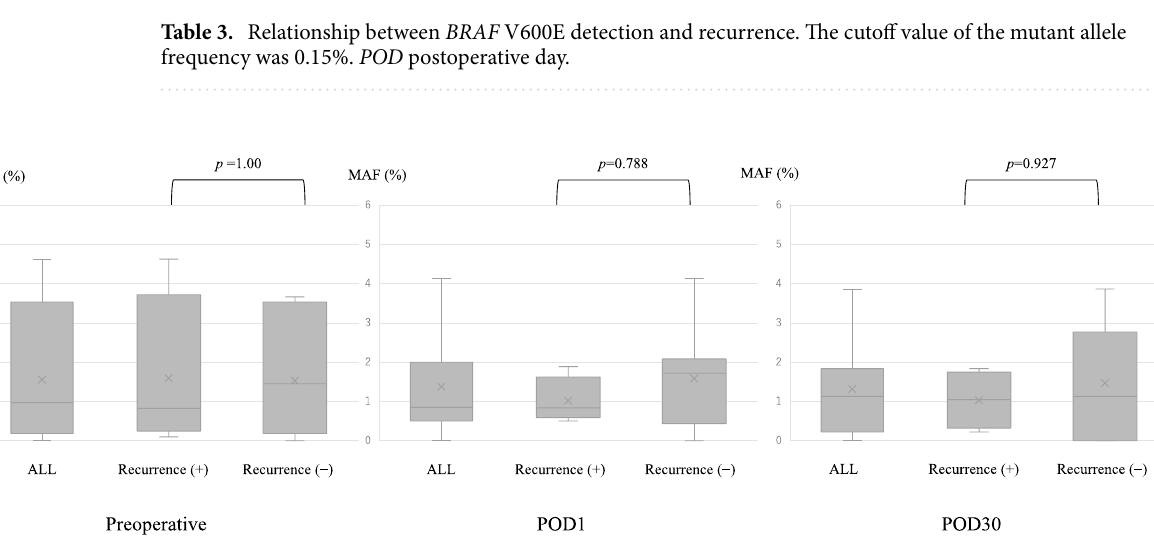
Figure 3. Relationship between the perioperative mutant allele frequency of BRAF V600E and recurrence. There was no significant difference between MAF preoperatively and on postoperative day (POD)1 and POD30 between recurrent and non-recurrent cases (Mann–Whitney U test; p = 1.00, p = 0.788, and p = 0.927,